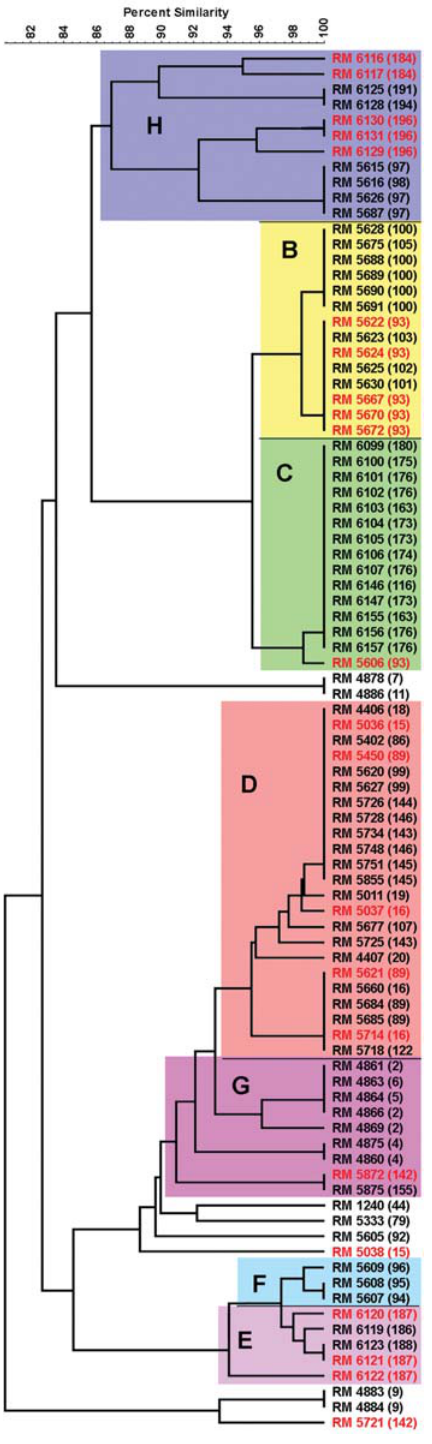
Figure 8. Dendrogram of selected isolates from PFGE data. Taxa are designated as RMXXXX ( ## ), where RMXXXX is the isolate name and ## is an arbitrary number assigned to that MLVA type [refer to Table S1]. Taxa in red type are identical MLVA types differentiated by PFGE. Colored clusters (labeled B–H) are similar to labeled MLVA clusters in Figure